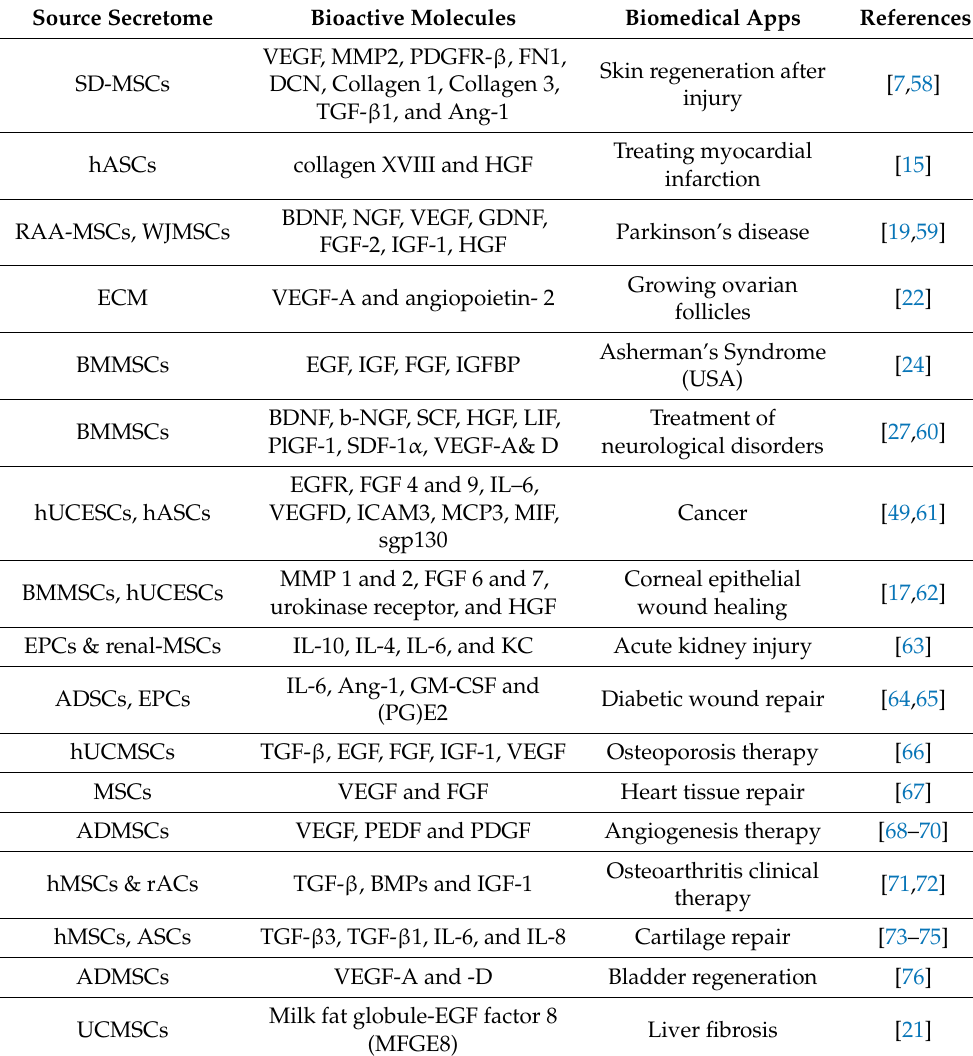
Table 1. Studies on the use of mesenchymal stem cell secretomes in biomedical